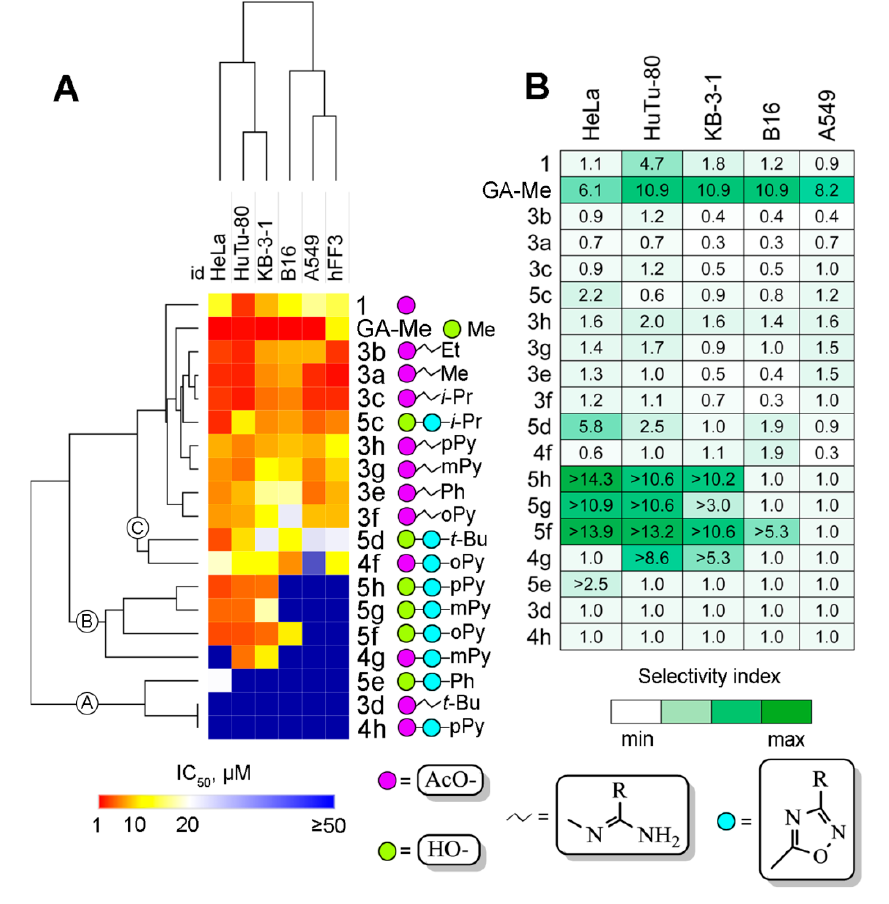
Figure 2. Cytotoxic profiles of novel GA derivatives. ( A ) Hierarchical clustering of IC 50 values of investigated compounds using Euclidean distance. ( B ) Heatmap illustrating the antitumor selectivity of action of the investigated derivatives. Selectivity index (SI) was calculated as the ratio of IC 50 values in normal hFF3 fibroblasts to the IC 50 values in corresponding malignant cells.